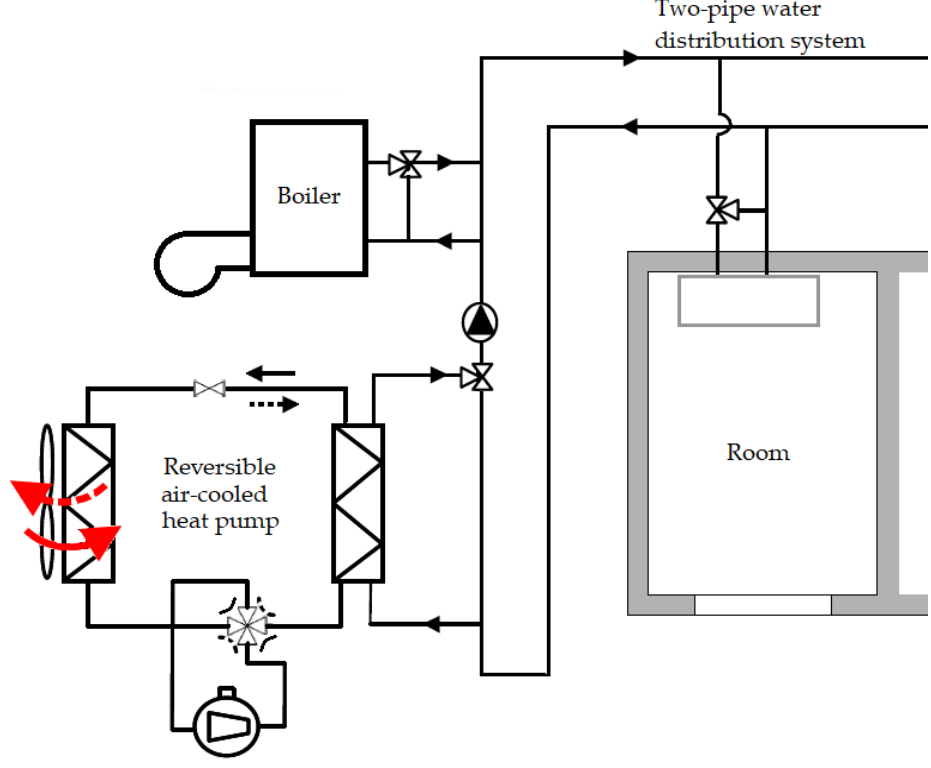
Figure 1. Reversible air-to-water unit, connected to a two-pipe distribution system in series with a